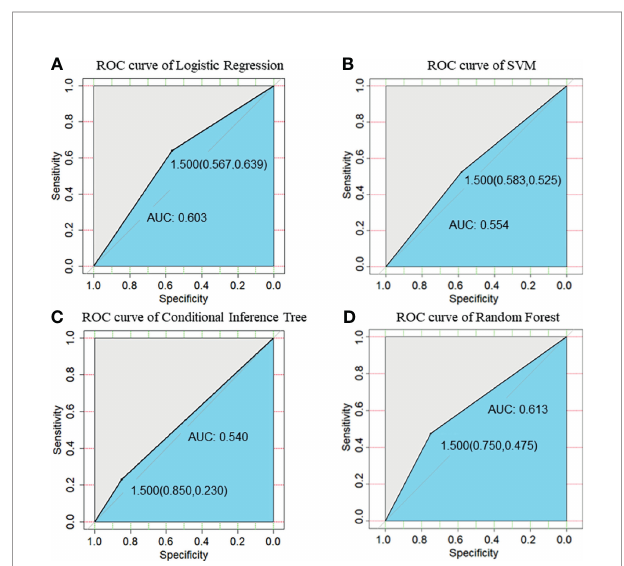
FIGURE 3 | ROC curve of prediction of clinical pregnancy with clinical characters. (A) ROC curve of Logistic Regression; (B) ROC curve of SVM; (C) ROC curve of Conditional Inference Tree; (D) ROC curve of Random Forest. Clinical characters included age, body mass index, serum estrogen level on the ET day, serum progesterone level on the ET day, endometrial thickness on the day of progesterone treatment, good-quality embryo rate and type of infertility (primary or secondary). SVM, support vector machine.